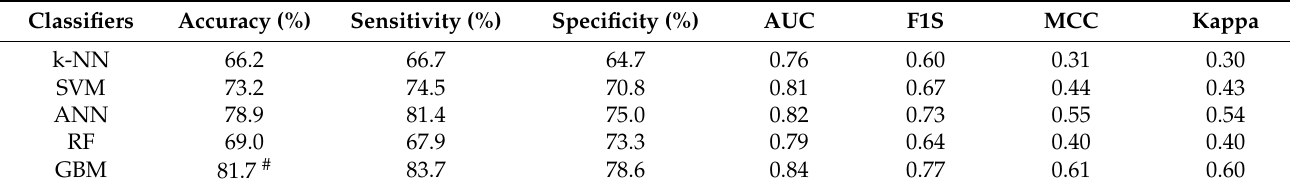
Table 4. Nested five-fold cross-validation classification performance for clinical data.